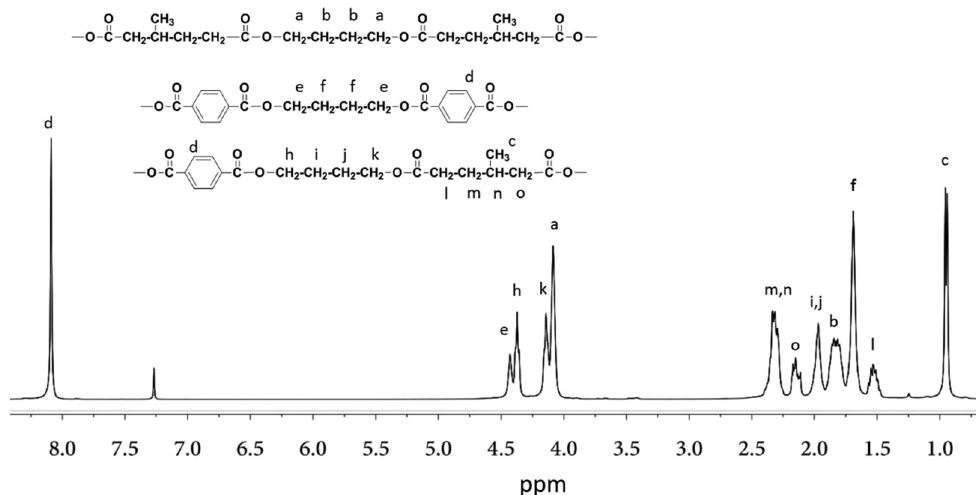
Figure 1: 1 H NMR spectrum and chain structures of PBA m